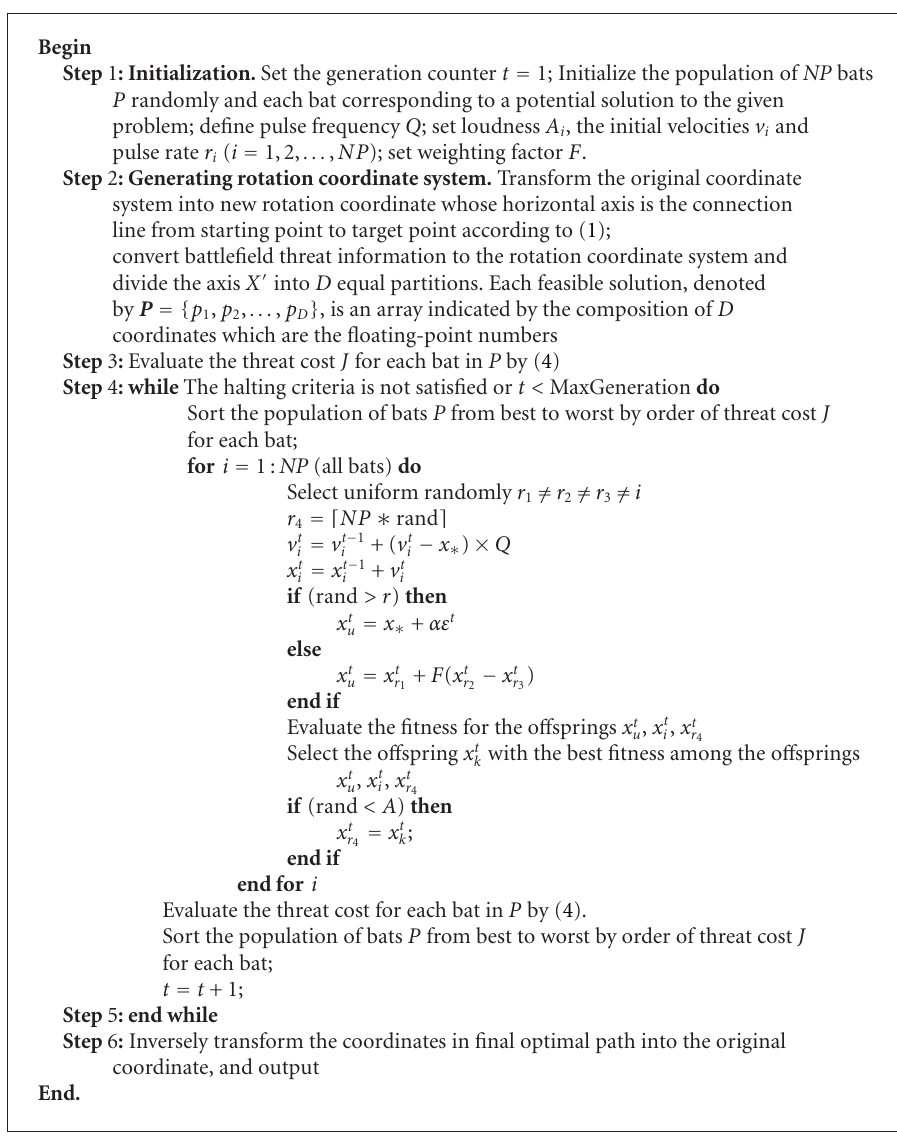
Algorithm 4: Algorithm of BAM for UCAV path